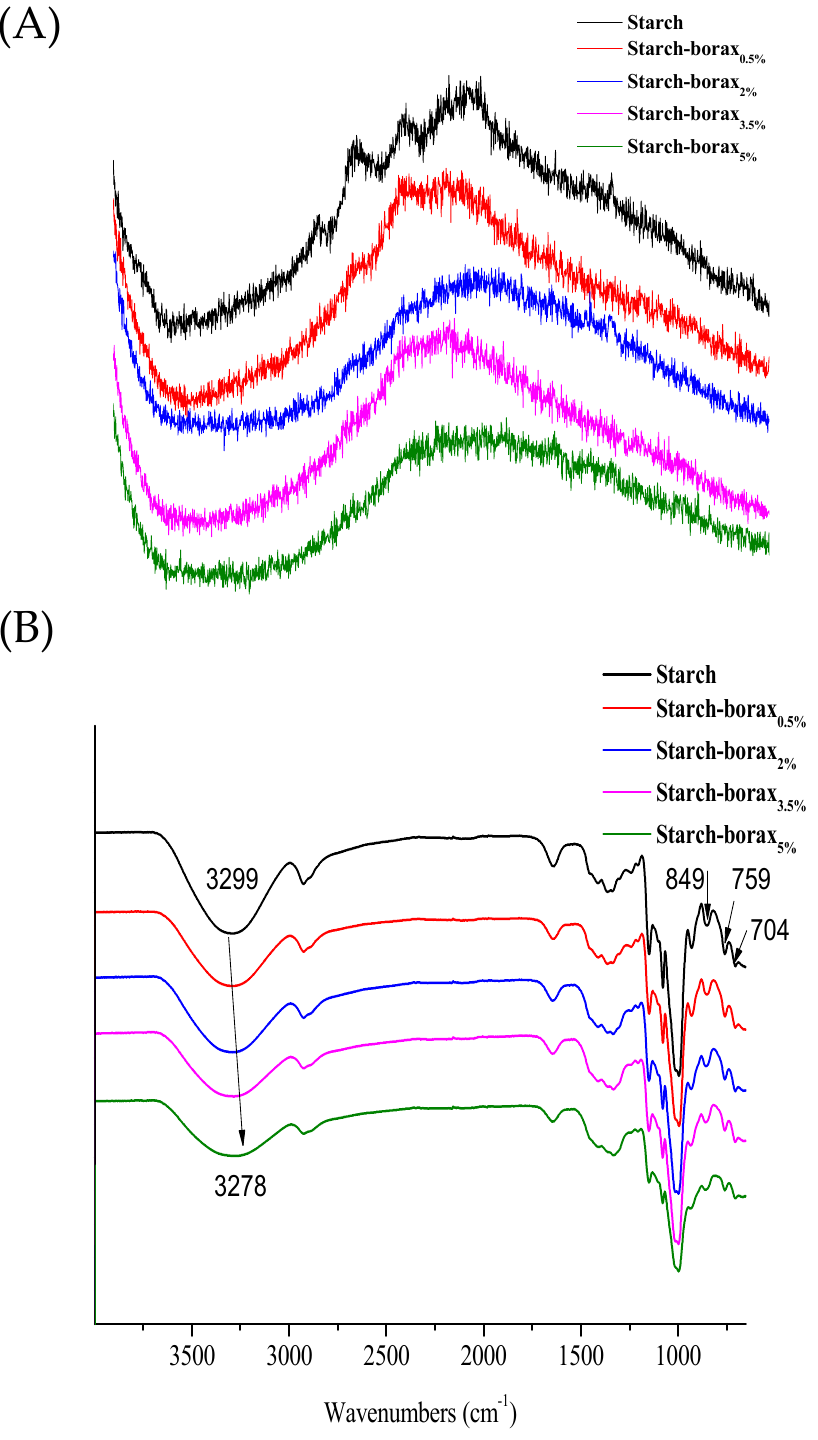
Figure 7. ( A ) X-ray diffraction pattern and ( B ) FTIR spectra of normal corn starch hydrogel and starch–borax DC hydrogels containing different amounts of borax.